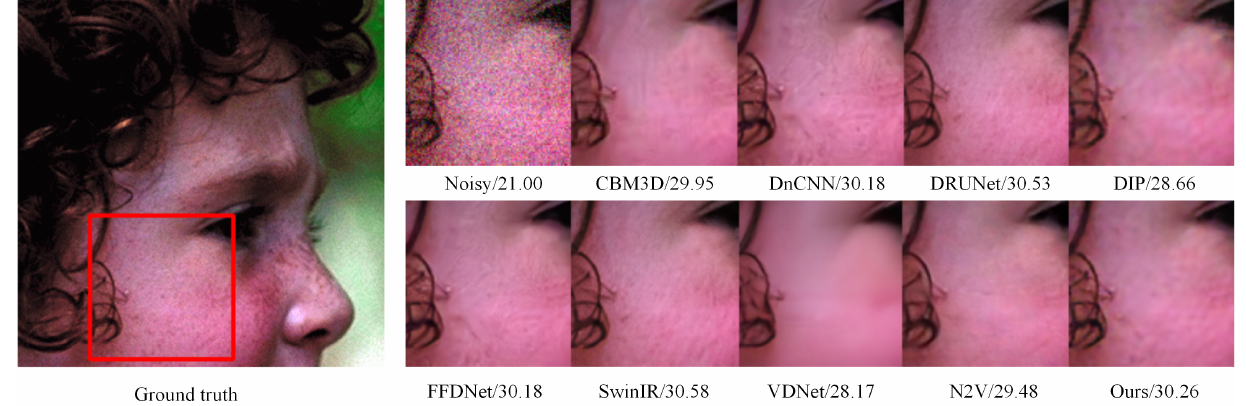
Figure 9. Visual comparison of the denoised results on the color image dataset. The quantitative PSNR results are listed behind the noisy and denoised